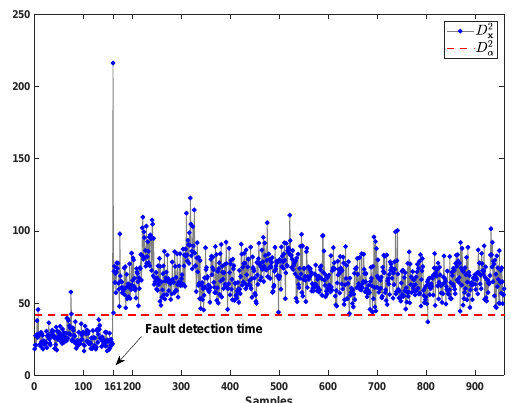
Figure 11. The fault detection results by kNN for fault 4 of Tennessee Eastman (TE).